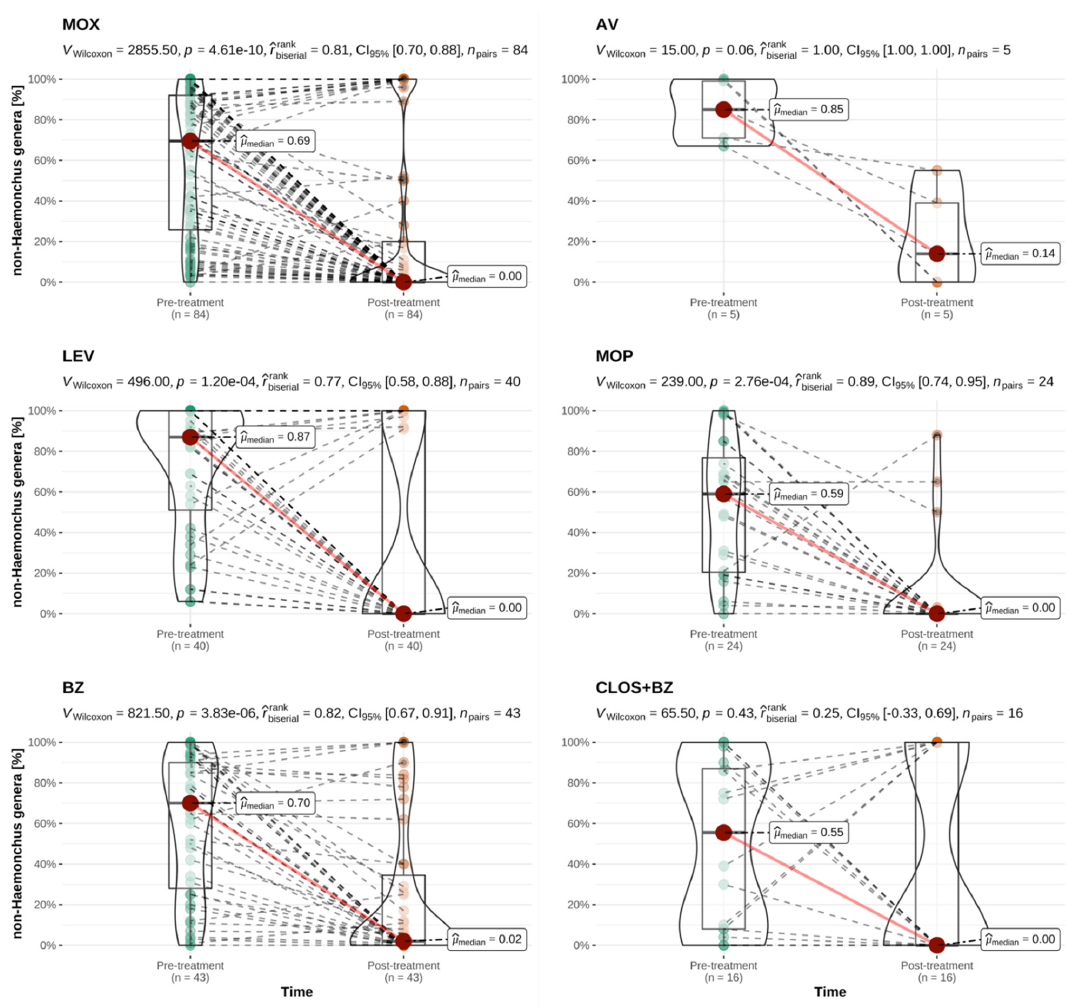
Figure 4. Paired comparison of the pre- and post-treatment percentage of non- Haemonchus strongyle eggs for treatments performed in sheep, by anthelmintic category. This analysis included all ovine treatments irrespective of their classification as successful or unsuccessful. MOX = moxidectin; AV = avermectins, LEV = levamisole; MOP = monepantel; BZ = benzimidazoles; CLOS + BZ = closantel and mebendazole; n = number of flocks treated per category with available paired results. r rankbiserial